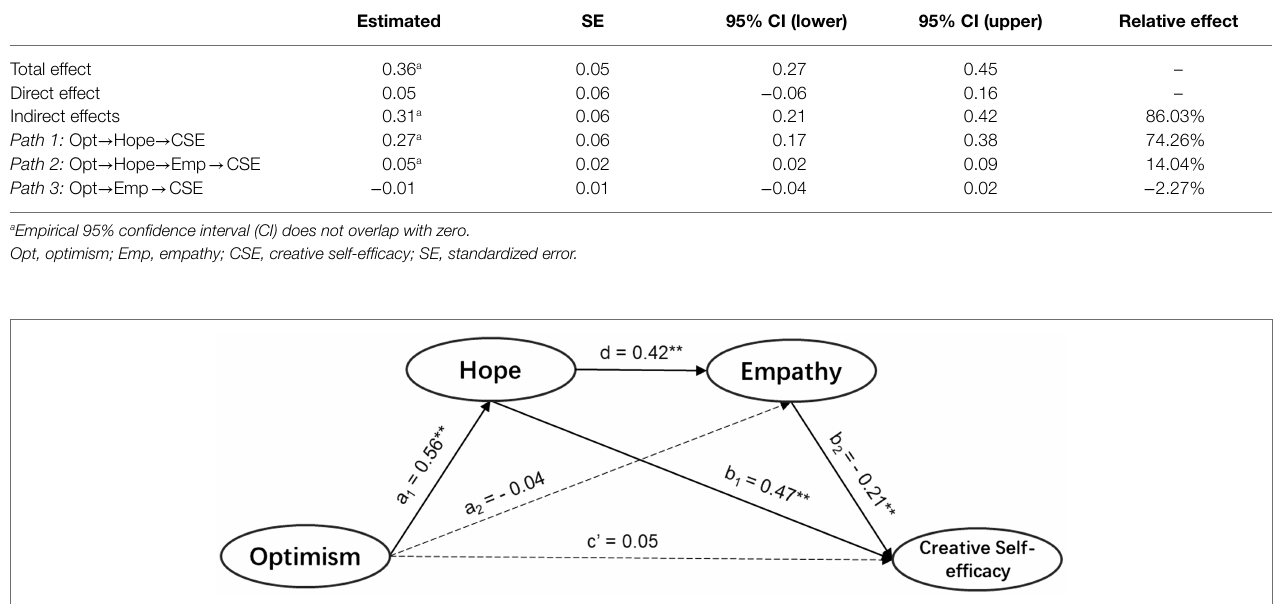
TABLE 3 | Direct and indirect effects of optimism on CSE through hope and empathy (three pathways for indirect effects). Estimated